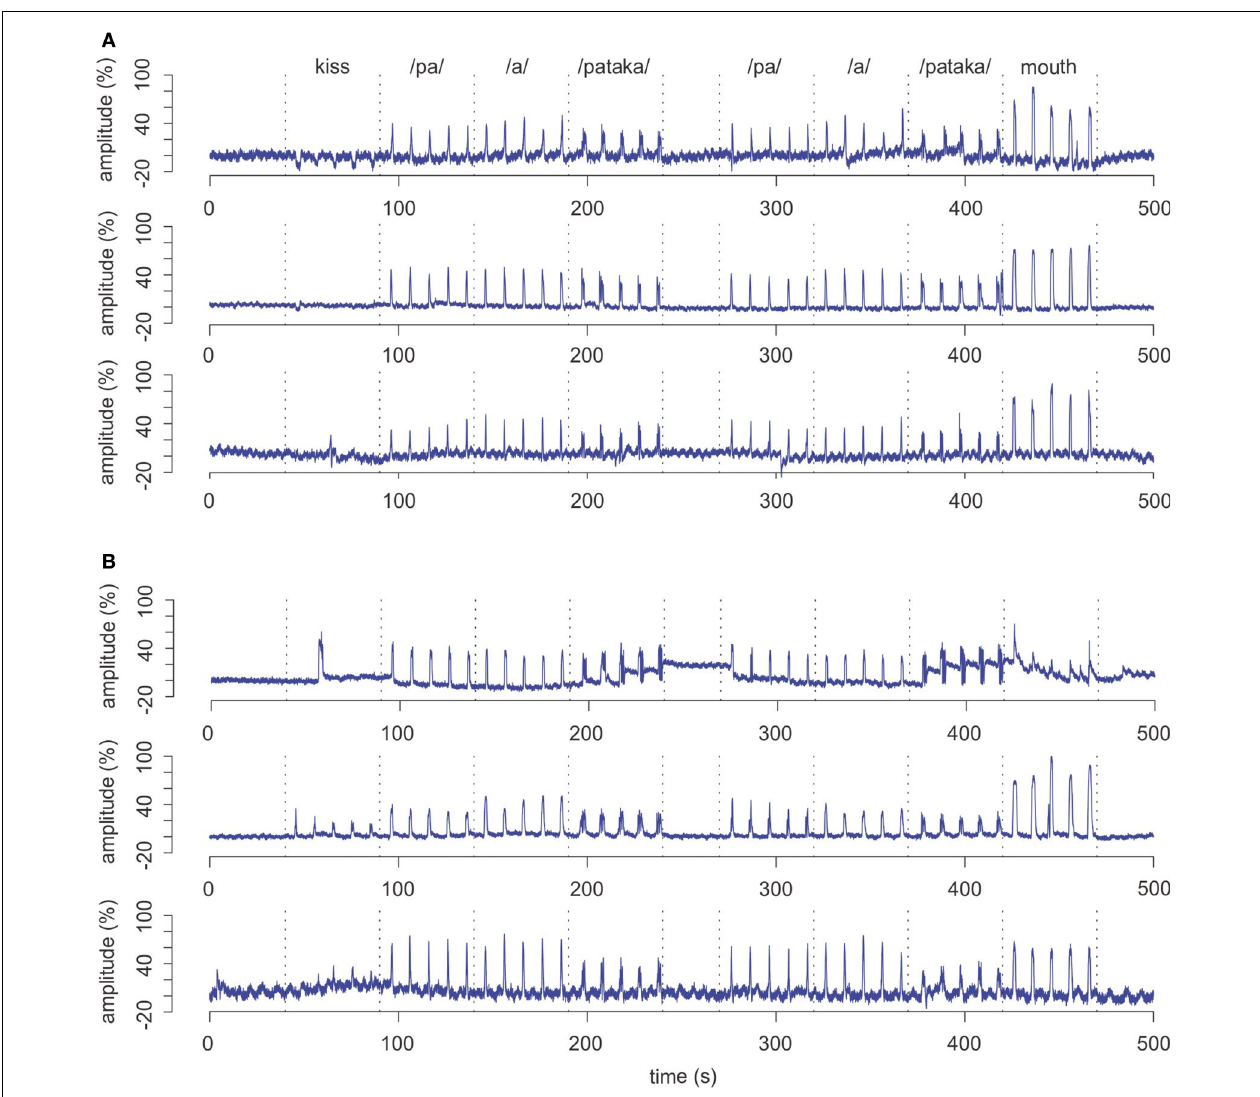
fi rst block) and normalized to the largest defl ection in the entire data set which was set to a relative amplitude of 100%. The dotted lines mark the beginning and end of blocks of fi ve responses. Kiss denotes protruding the lips. Mouth denotes opening the mouth without producing an